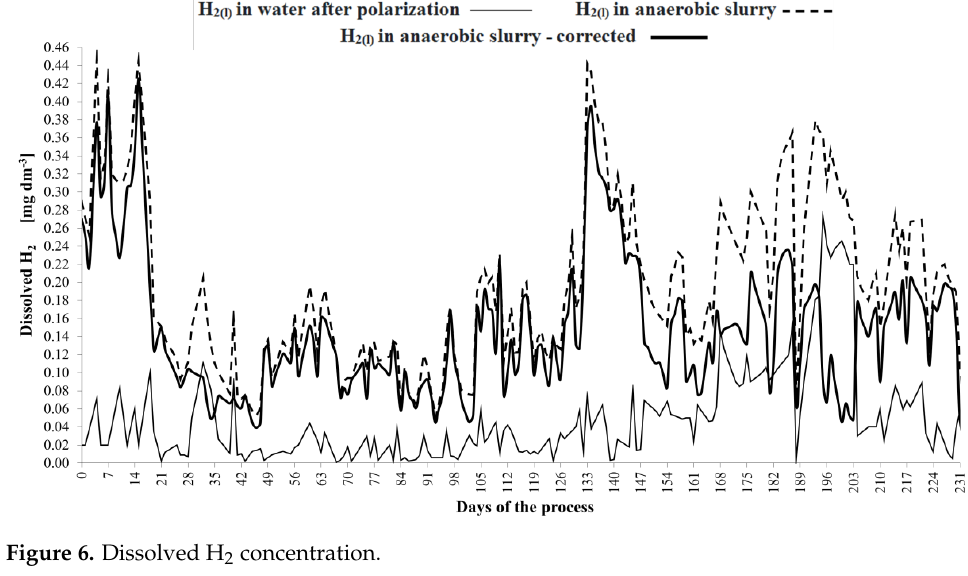
Figure 6. Dissolved H 2 concentration.